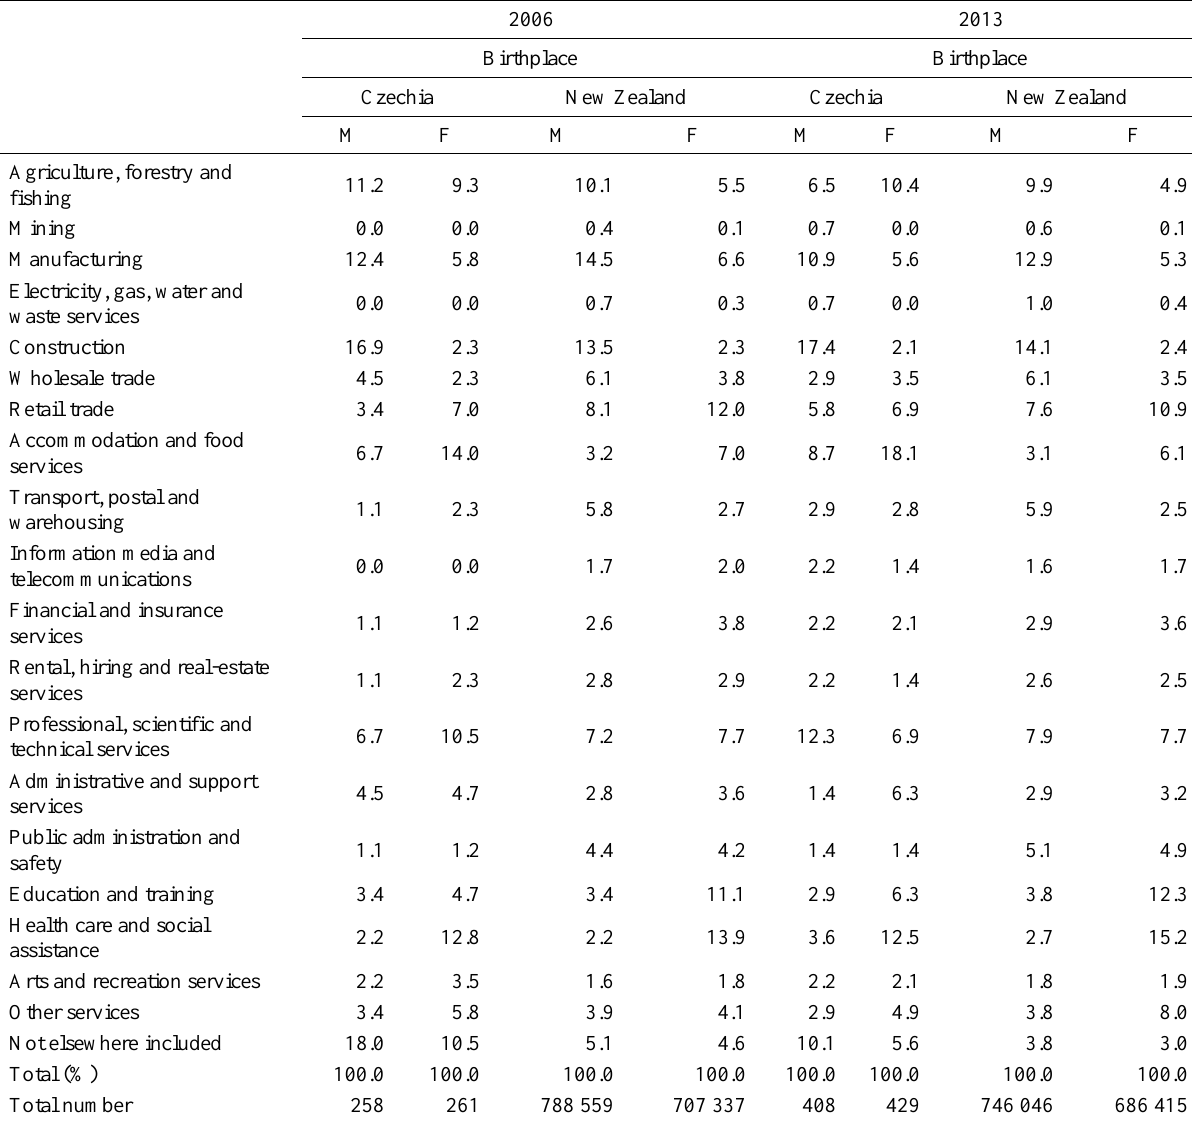
Table 9. Employment in industries by birthplace and gender for employed population resident in New Zealand aged 15 and over (%), 2006 and 2013 censuses 2006